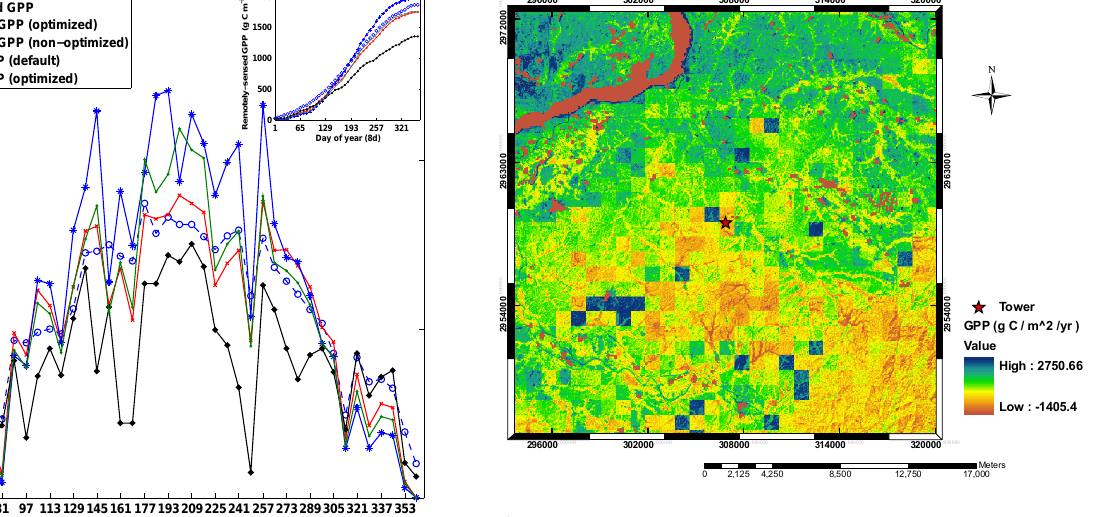
Fig. 9. Differences in annual total gross primary productivity (GPP) between the values derived from the synthetic LANDSAT- like images with the optimized footprint integrated algorithm and the MODIS products (LANDSAT – MODIS) in 2004 in an ev- ergreen needleleaf forest over a 30km × 30km region centered at QYZ,